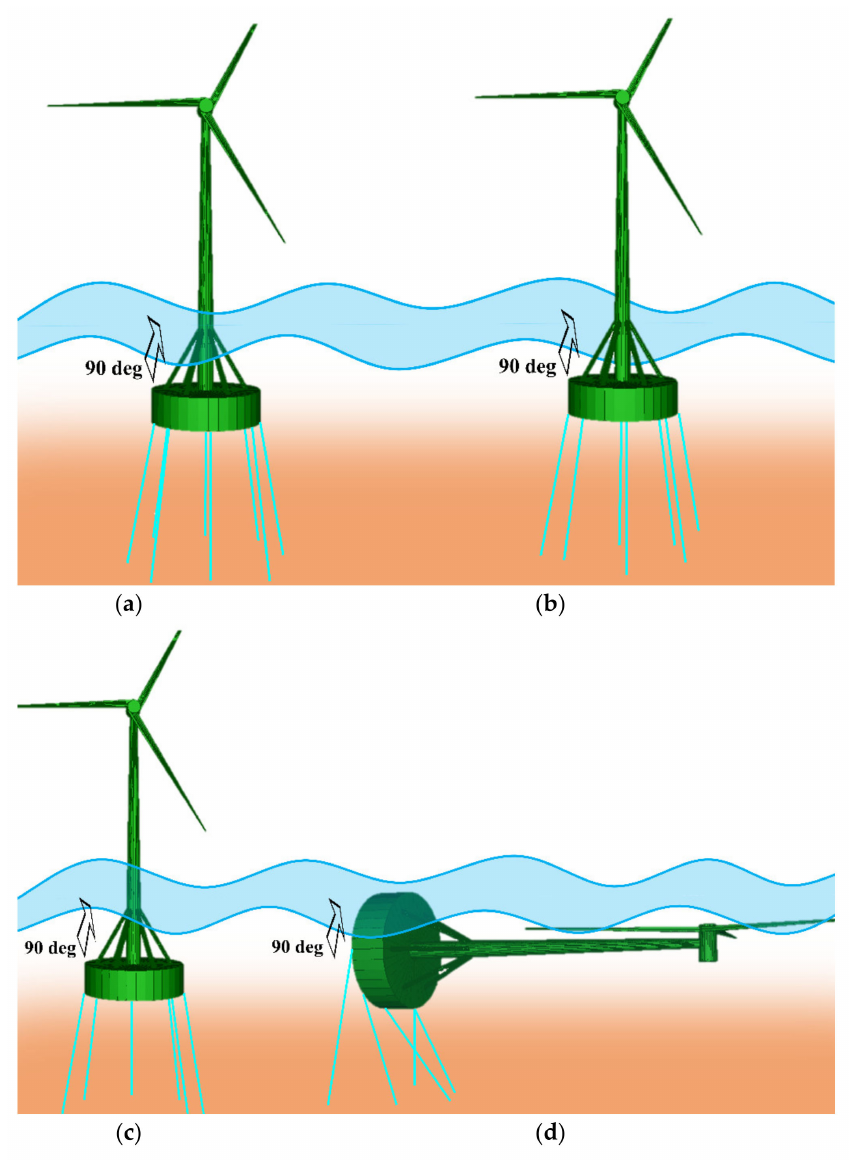
Figure 11. Failure analysis of tension legs under the 8 tension legs condition: ( a ) normal, ( b ) failure of p1, ( c ) failure of p1 and p6, and ( d ) failure of p1, p6, and p3